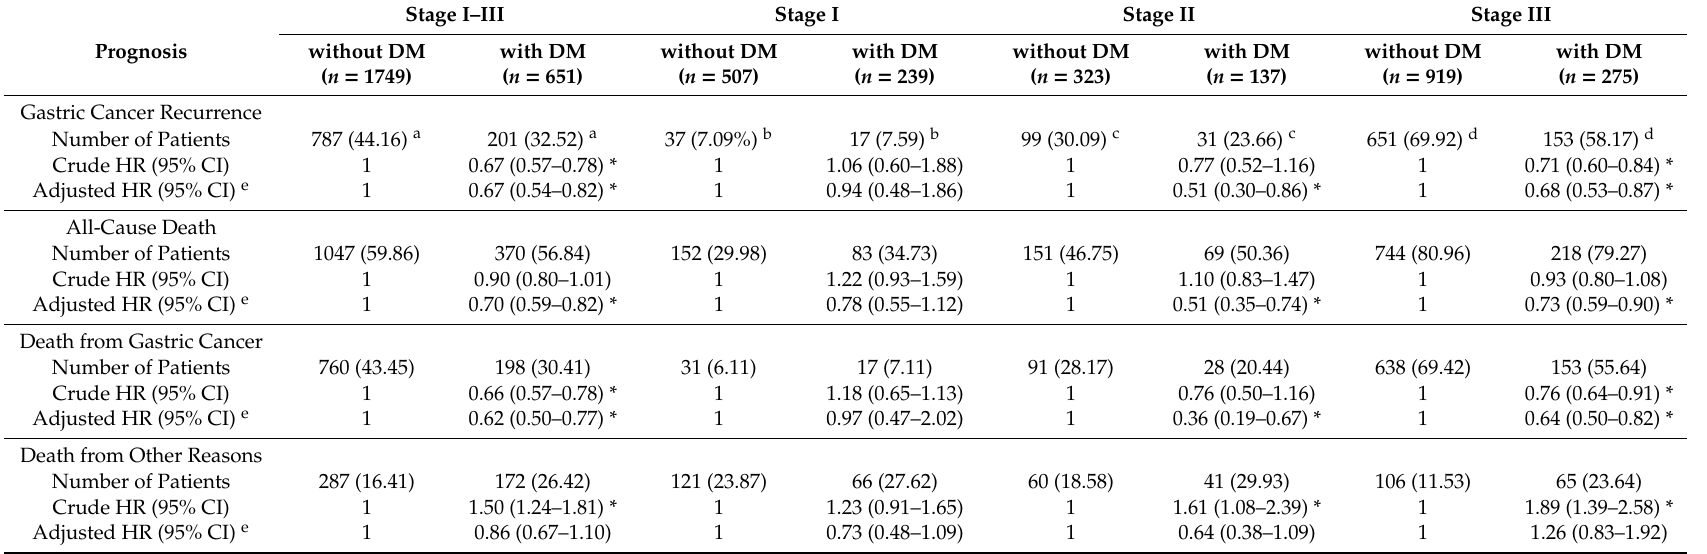
Table 3. Recurrence and death in GC patients with and without DM, stratified by